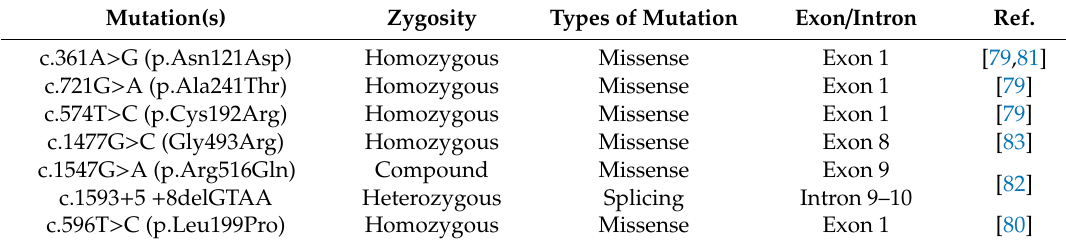
Table 2. FLVCR1 mutations reported in PCARP patients so